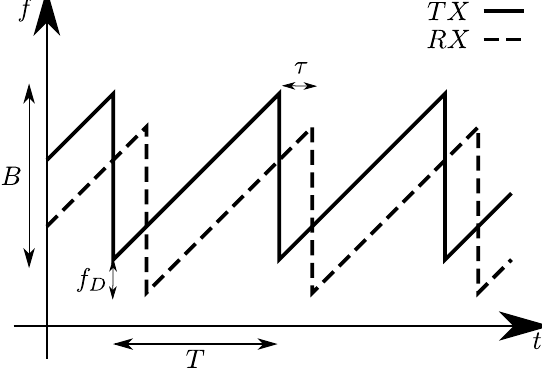
Figure 4. FMCW transmitted and received